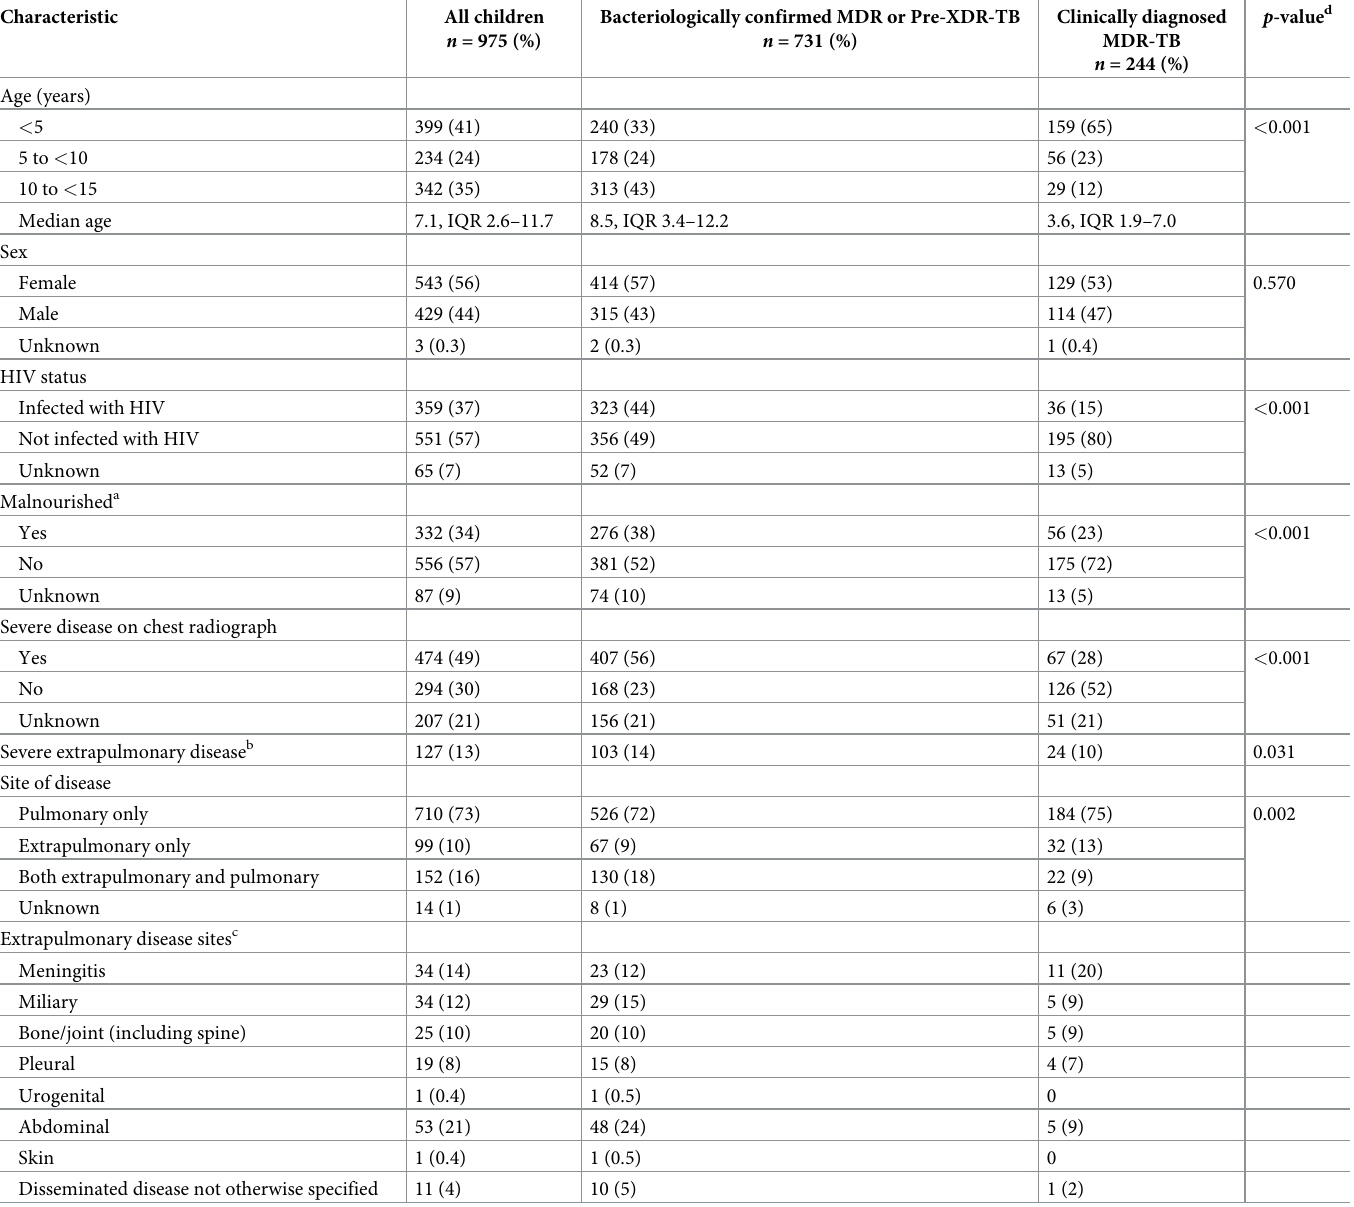
Table 2. Demographic and clinical characteristics among children with MDR-TB.